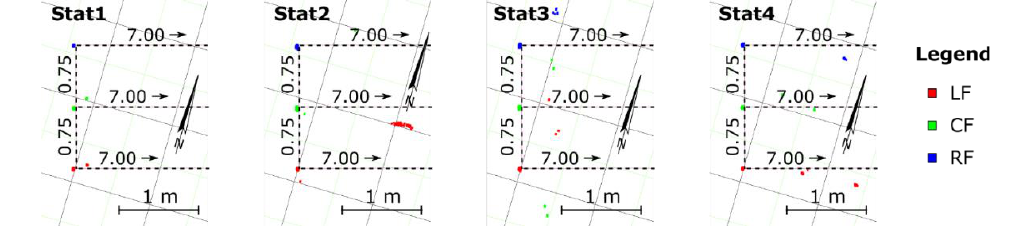
Figure 5. Front- line receivers’ post -processed coordinates from four sessions. Figure 5. Front-line receivers’ post-processed coordinates from four